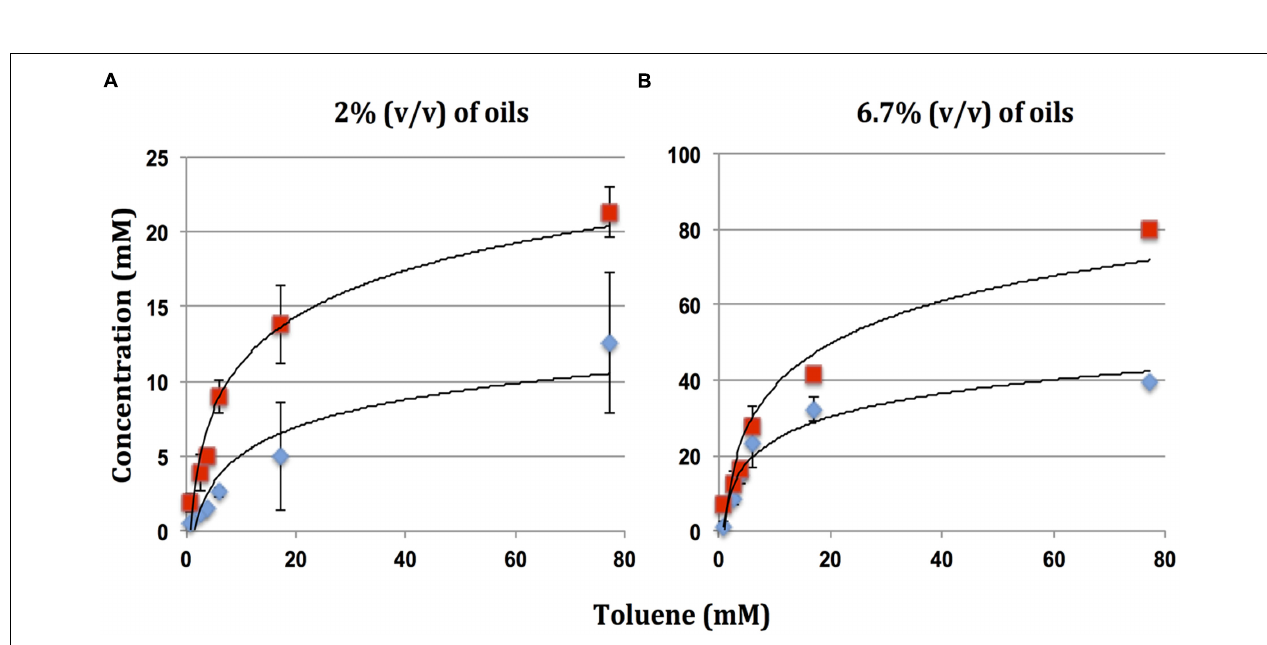
FIGURE 4 | Maximum reduction of nitrate ( (cid:4) ) and formation of nitrite ( (cid:7) ) in microcosms incubated with oils with different toluene concentrations for 90 days. Data are for (A) serum bottles and (B) Hungate tubes. Error bars represent the standard deviations for eight replicate measurements.